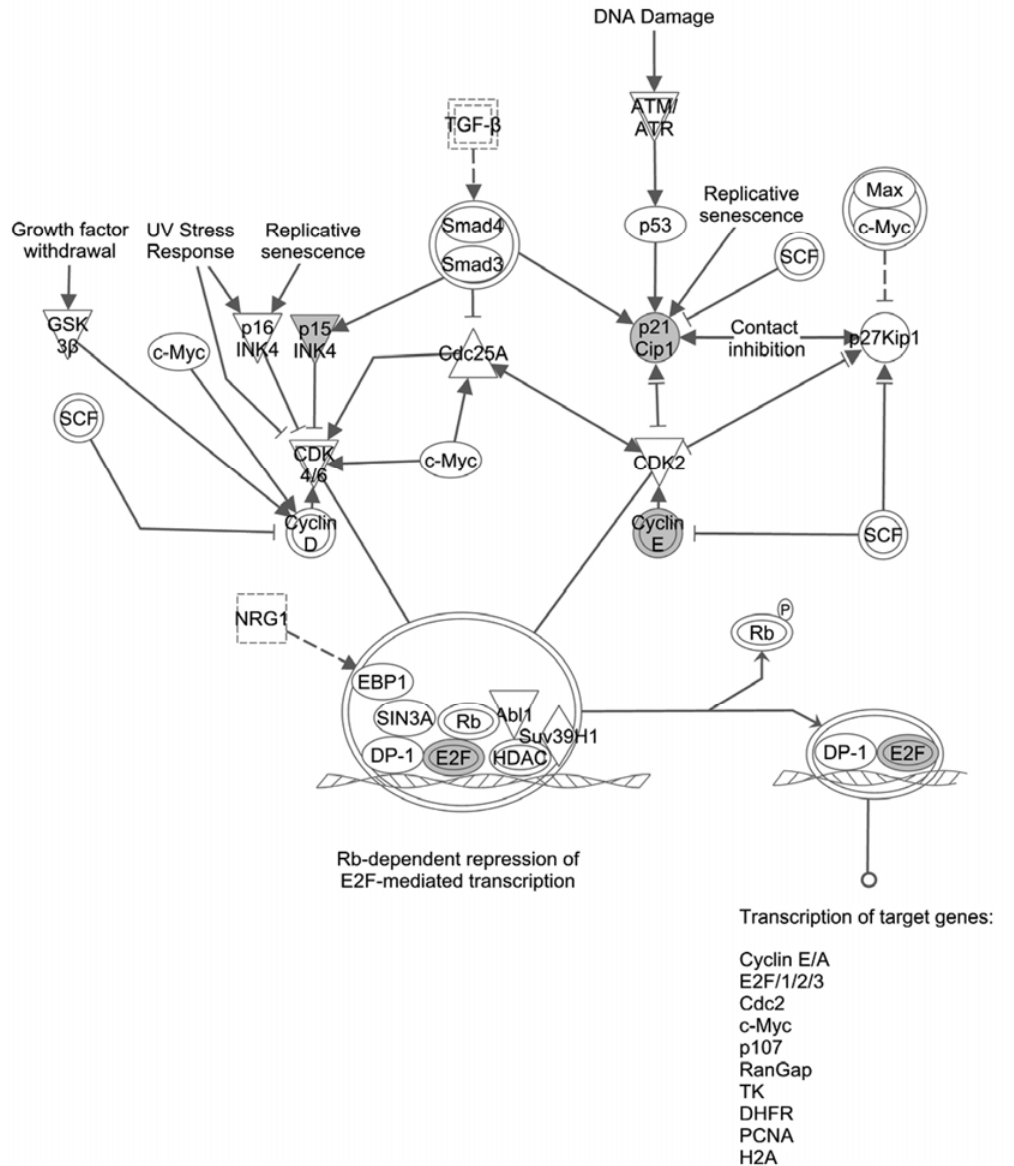
Figure 3. Genes with altered expression upon miR-224 stimulation are involved in the G1/S checkpoint. P15, p21, and CCNE1 were identified to be regulated by miR-224. They are involved in the final steps of G1/S checkpoint regulation. Decreasing levels of these molecules would result in increased phosphorylated Rb (p-Rb), with the end result being the release from the G1/S